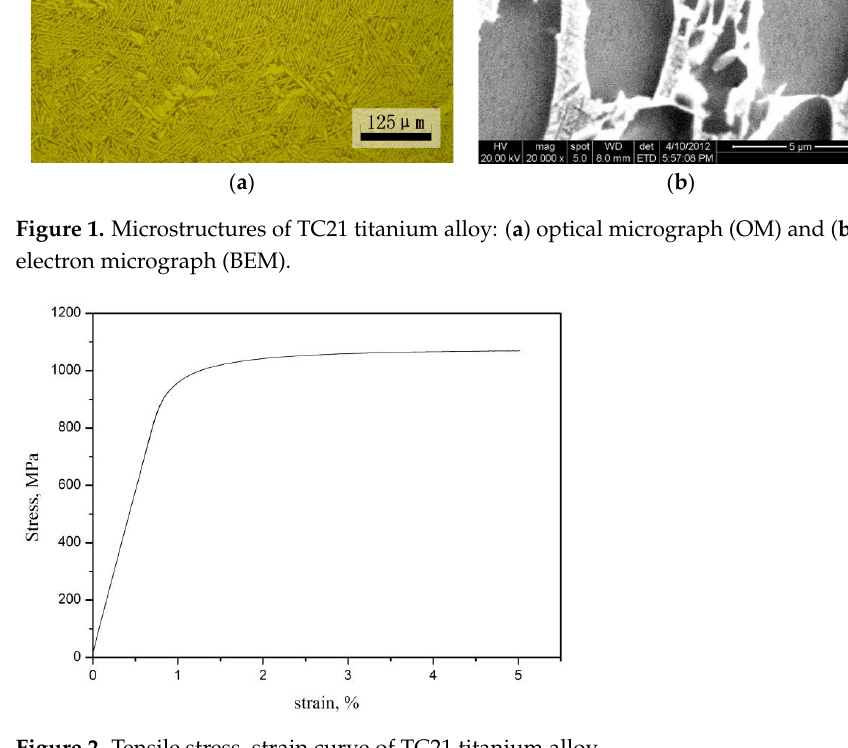
Figure 2. Tensile stress–strain curve of TC21 titanium alloy.